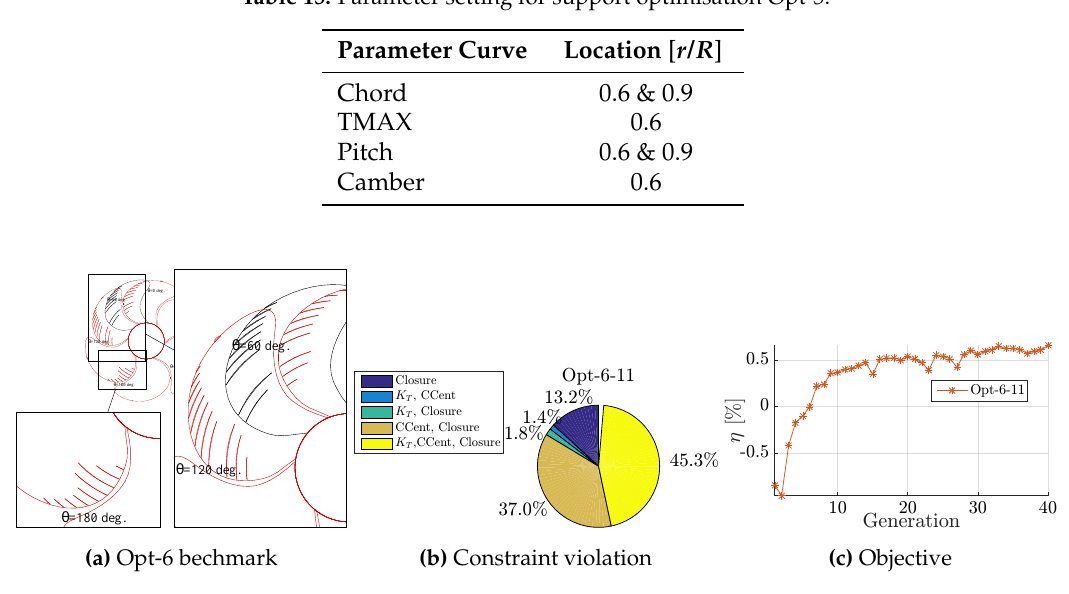
Figure 24. Optimisation Opt-6, baseline cavitation performance ( a ); classification of individual constraints violation ( b ); and median performance of single-objective η ( c